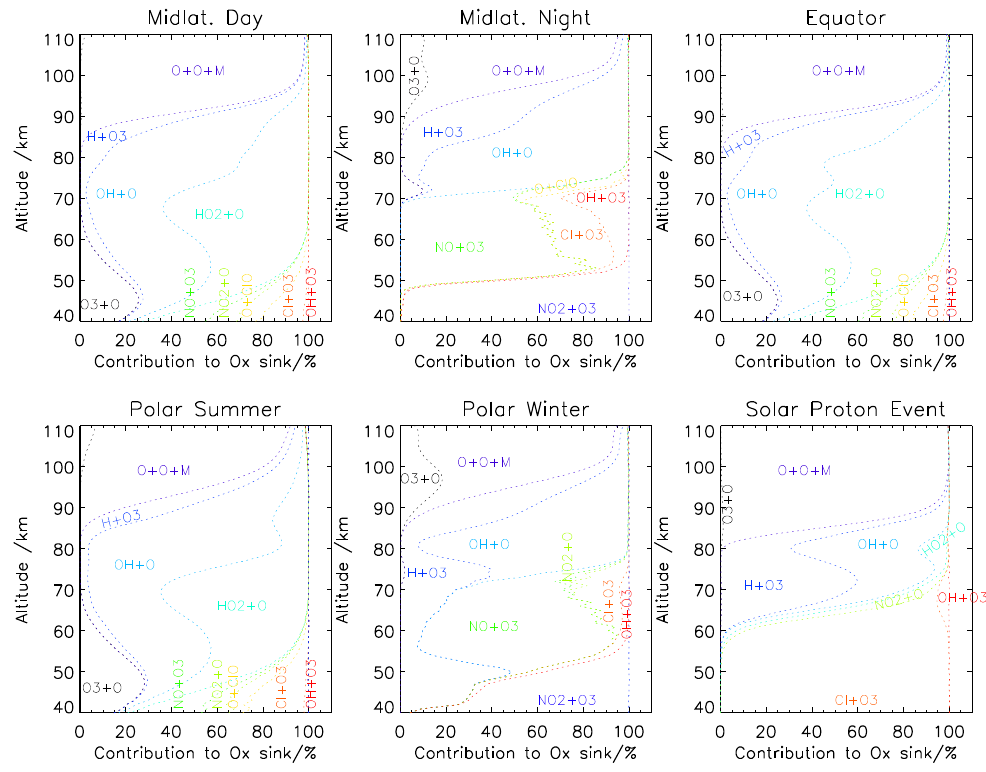
Fig. 4. Cumulative relative contribution to the odd oxygen sink of the leading reactions for various atmospheres.